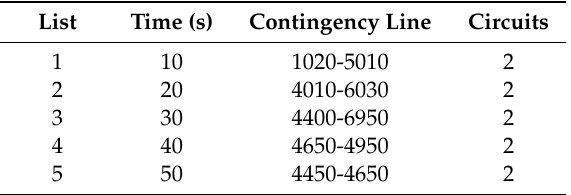
Table 1. Series contingency scenario on the transmission lines.